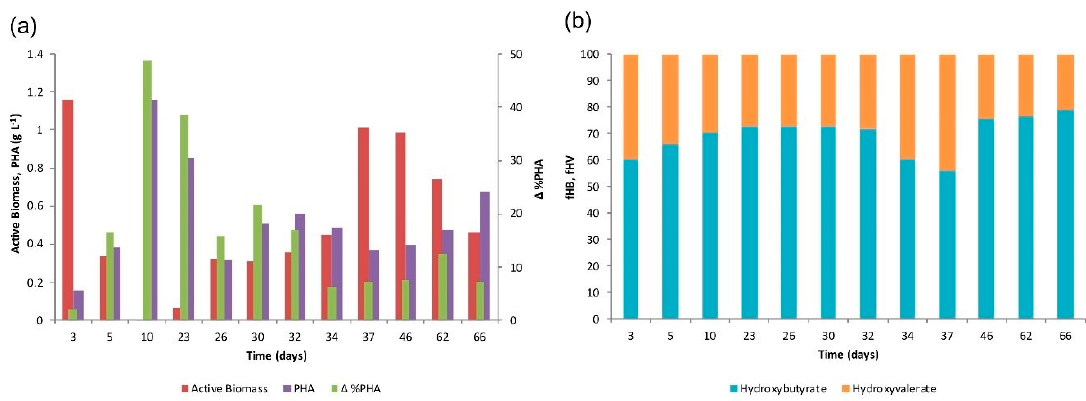
Figure 2. Evolution of ∆ %PHA (green bar), Active Biomass (red bar), and PHA concentrations (purple bar) ( a ) and contents of 3HB (blue bar) and 3HV (orange bar) ( b ) throughout the SBR operational time.